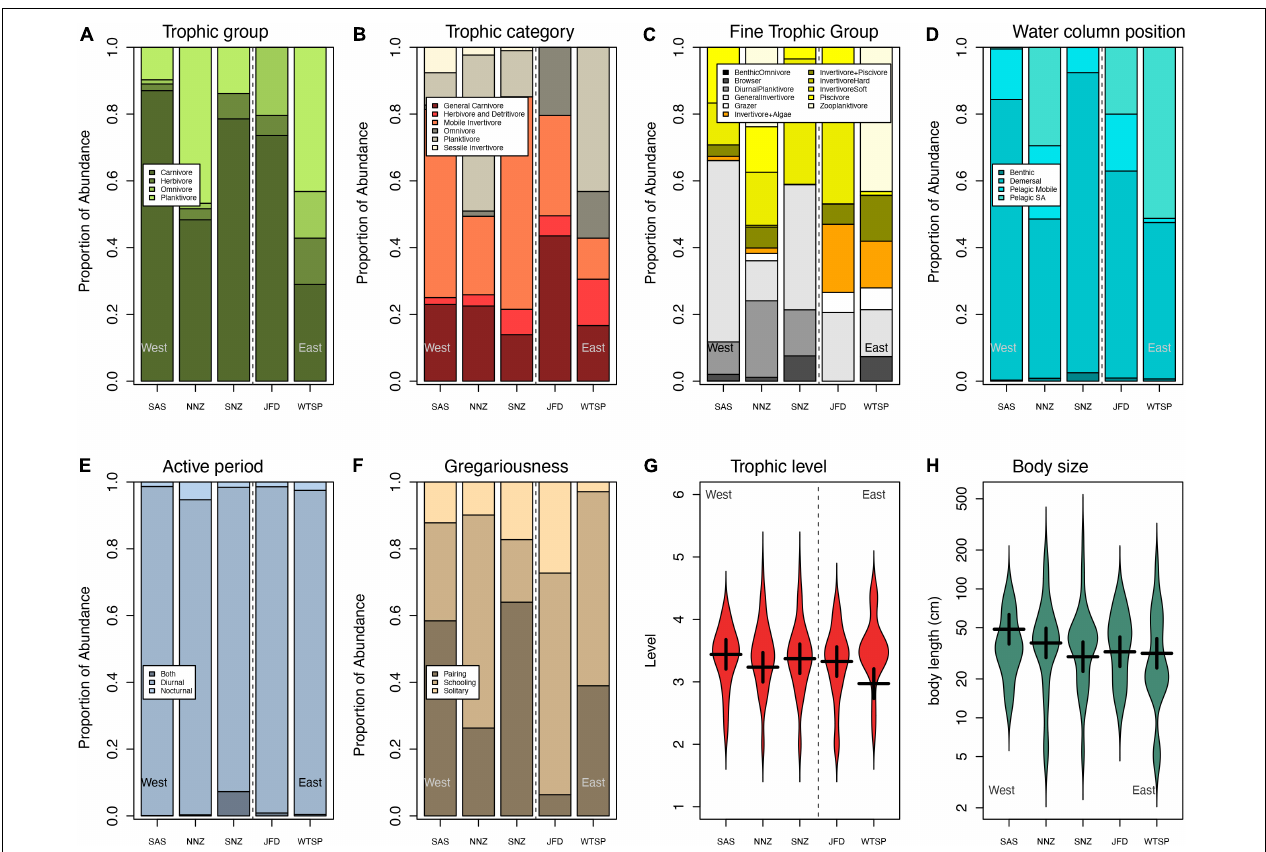
FIGURE 4 | Functional traits of species (A) the proportion of the abundance within coarse trophic groups (i.e., planktivore, herbivores, omnivores, and carnivores), (B) proportion of the abundance within different trophic categories (general carnivores, mobile invertivores, omnivores, planktivores, and sessile invertivores), (C) fine-feeding guilds (planktivores, benthic omnivores, browser and grazer herbivores, invertivores of soft, hard, both types of prey, invertivores and piscivores, and piscivores); (D) proportion of the abundance of species within water column position (benthic species, demersal, pelagic mobile, and Pelagic site attached); (E) proportion of the abundance within Active period (diurnal, nocturnal, or both species); (F) proportion of the abundance Gregariousness (solitary, pairing, schooling species); violin plots depicting the median (black bar), the horizontal dotted line facilitating comparison of multiple provinces, the upper and lower adjacent values, the first and the third quantile (depicted by the vertical dotted lines) and outside points depicted by the narrow vertical line of (G) trophic level, and (H) max body size at the 5 sampled provinces such as Southeast Australian Shelf (SAS), Northern New Zealand (NNZ), Southern New Zealand (SNZ), Juan Fernandez and Desventuradas (JFD), Warm Temperate Southeastern Pacific